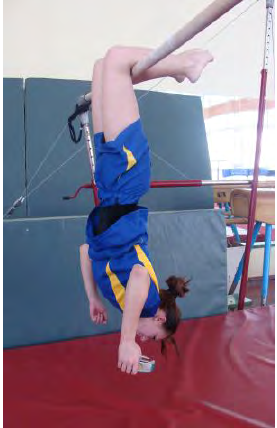
Fig.8. Proprioceptor sensitiveness